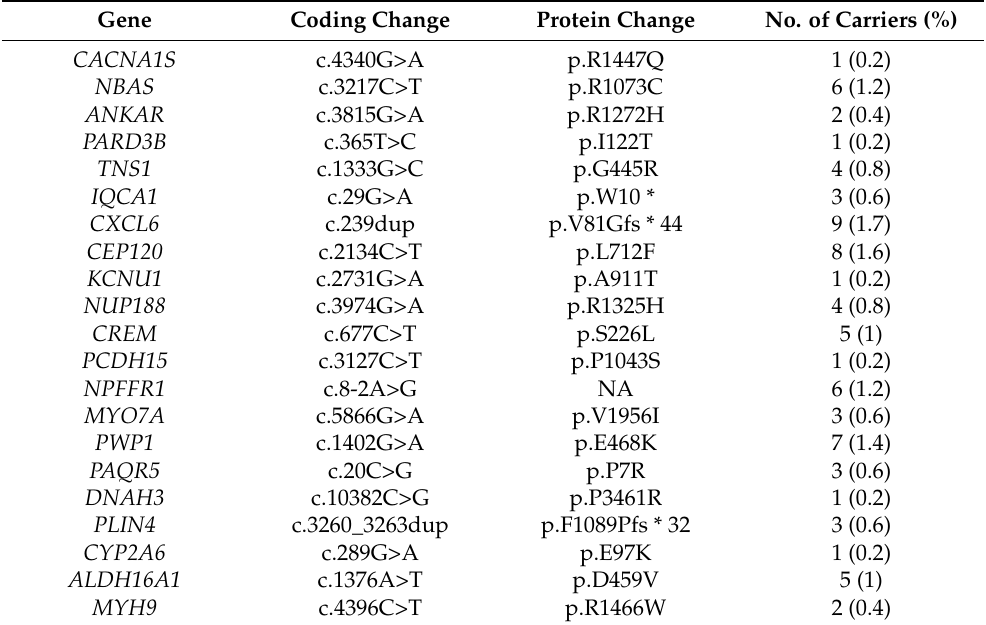
Table 2. Genetic landscape variants identified in Australian HGSC cases (n = 516).